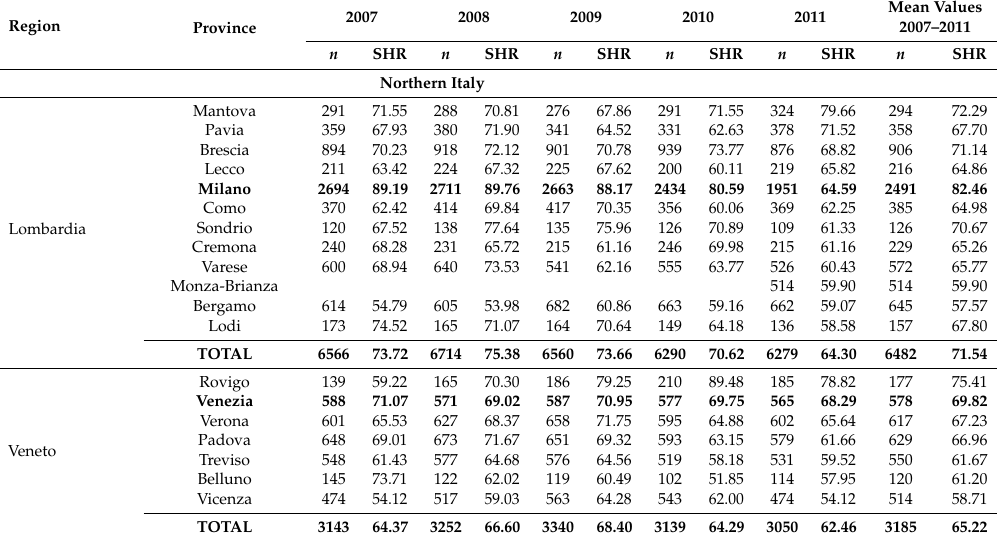
Standardized hospitalization rate (SHR) per 100,000 and overall number of new hospitalizations due to cancer per region and province from 2007 to 2011. Adults aged 20–49 years old.